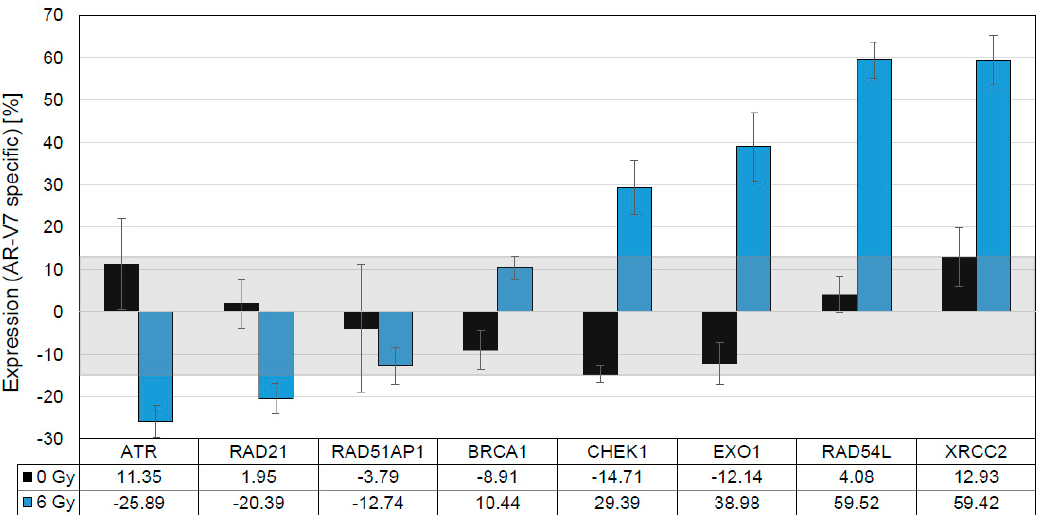
Figure 9. Validation of upregulated DNA repair genes of the AR splice variant expressing CRPC. LNCaP overexpressing AR-V7 served as a surrogate for CRPCs expressing AR-Vs. DNA repair genes upregulated in CRPC+AR-Vs (Figure 7B) were validated by qRT-PCR under irradiated (6 Gy, IR, blue bars) and non-irradiated (0 Gy, Ø, black bars) androgen-deprived conditions. The latter condition, with generally lower AR-V7-specific expression, served as the threshold (light gray box) to identify genes (CHEK1, EXO1, RAD54L, XRCC2) strongly upregulated by irradiation.